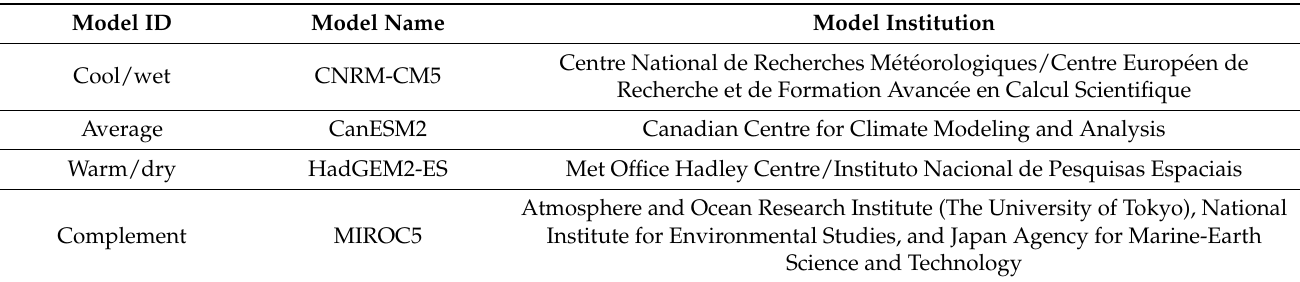
Figure A2. Historical water year type classification in the San Joaquin River region. Table A1. GCMs selected for this study 1